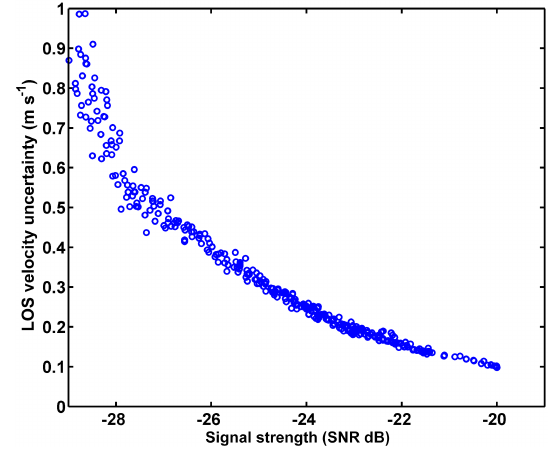
Figure 6. Estimate of the standard deviation of random error as a function of signal-to-noise ratio estimated using Lenschow et al.